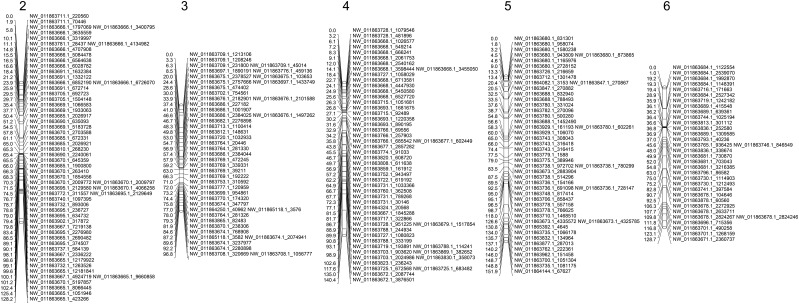
Linkage map. Genetic map depicting size of linkage group in centimorgan and distribution of SNPs in five linkage groups.